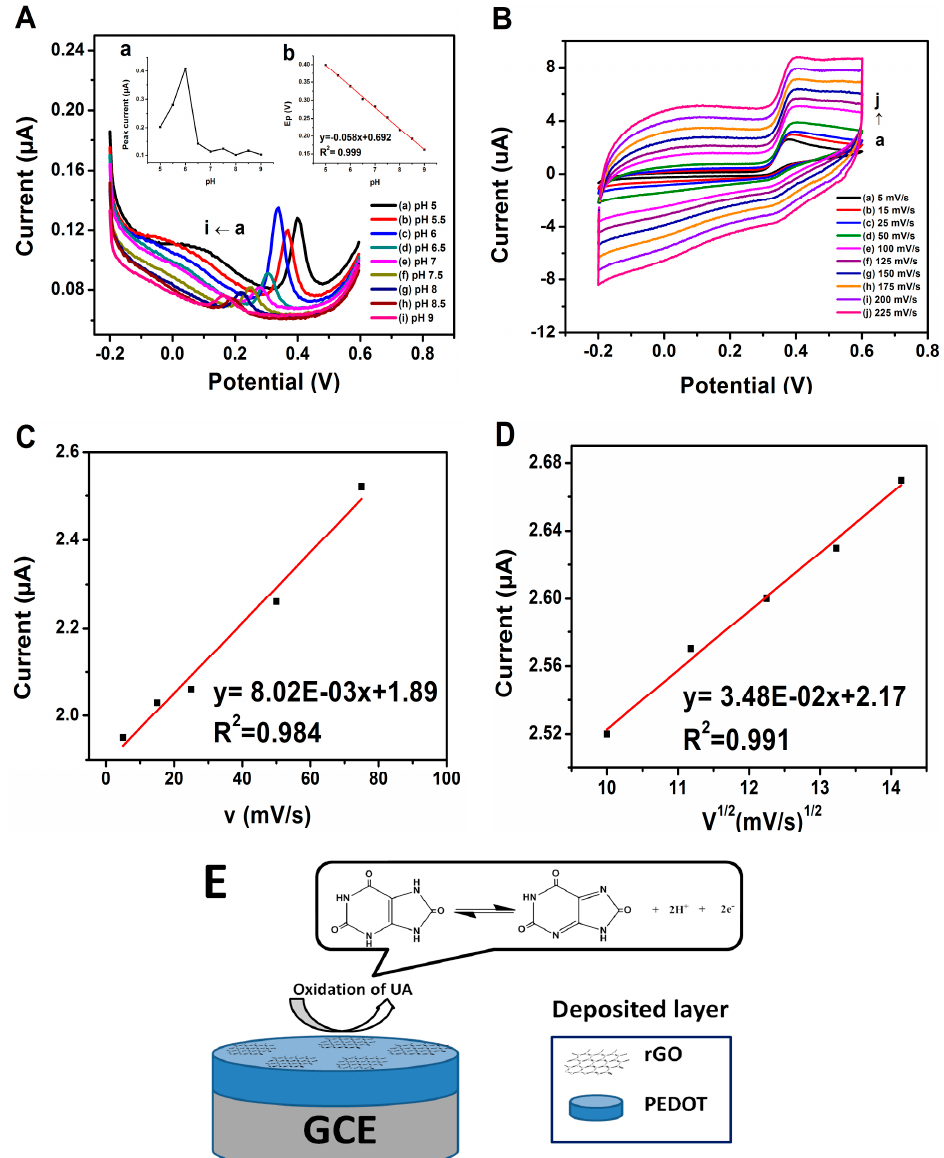
Figure 4. ( A ) DPV of PrGO in 0.1 M PBS of 20 μ M of UA at different pH values (pH: 5, 5.5, 6, 6.5, 7, 7.5, 8, 8.5, 9) inset (a) Peak current ( I pa ) vs pH (b) Potential (V) vs pH of 0.1 M PBS of 20 μ M UA. ( B ) CV of 450 μ M UA with various scan rates for PrGO in PBS at pH 6.0. Anodic peak currents ( I pa ) as a function of a ( C ) scan rate ( D ) square root of scan rate for the effective working surface area determination. ( E ) Schematic illustration of UA sensing mechanism on PrGO composite.